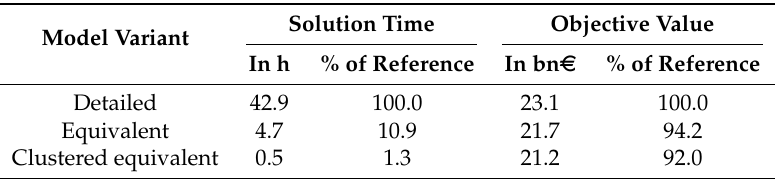
Table 3. Comparison of solution time and objective